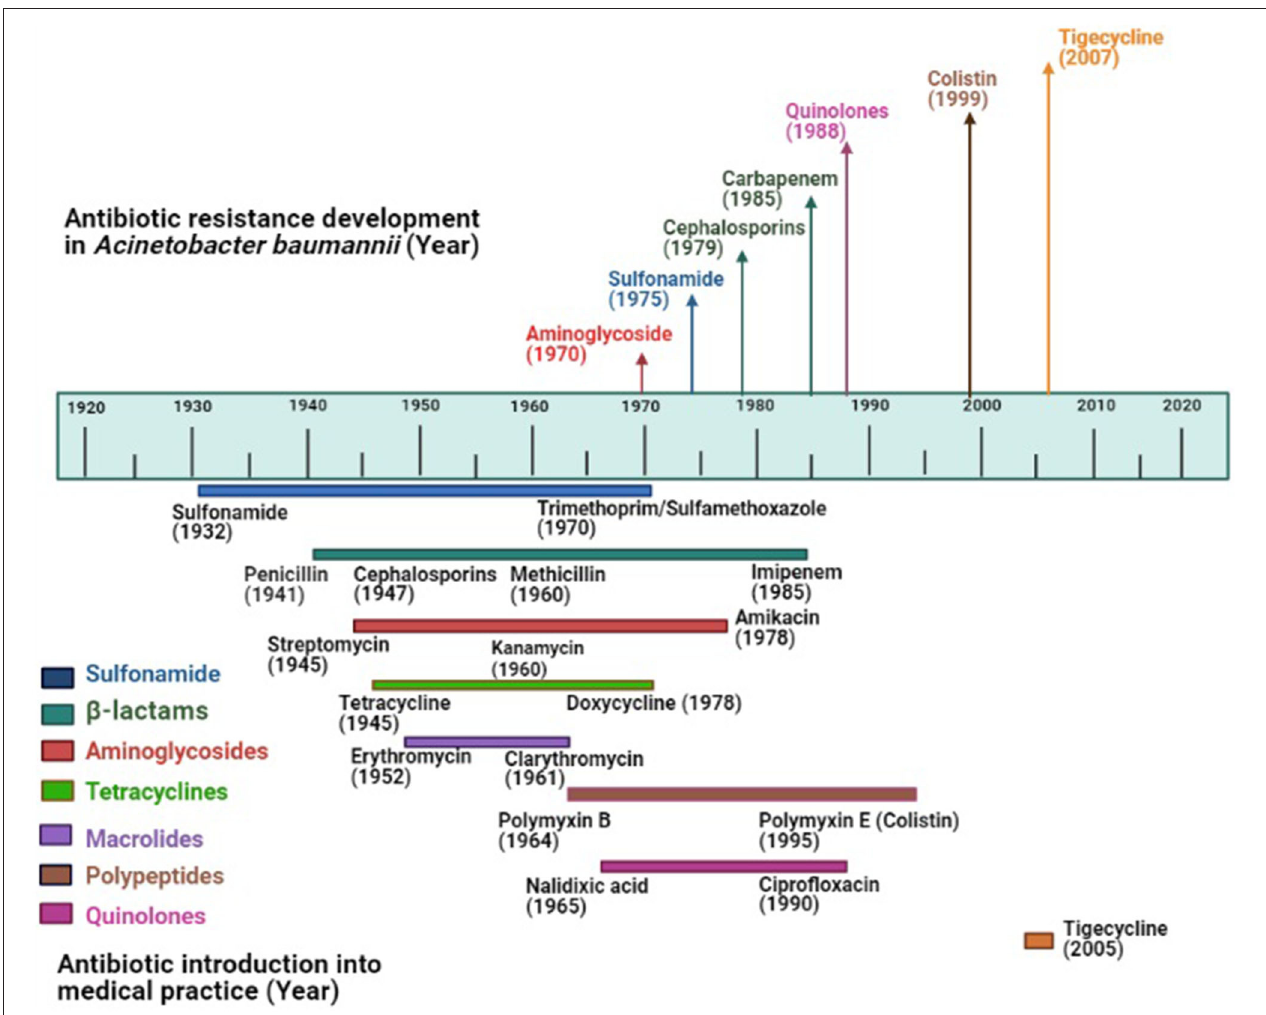
FIGURE 1 | Evolution of antimicrobial resistance among Acinetobacter baumannii : Top portion of the diagram shows the year of the first report of antimicrobial resistance in A. baumannii ; the lower portion shows the year of introduction of antimicrobials (approximate year) in the market where colored lines indicate different antimicrobial